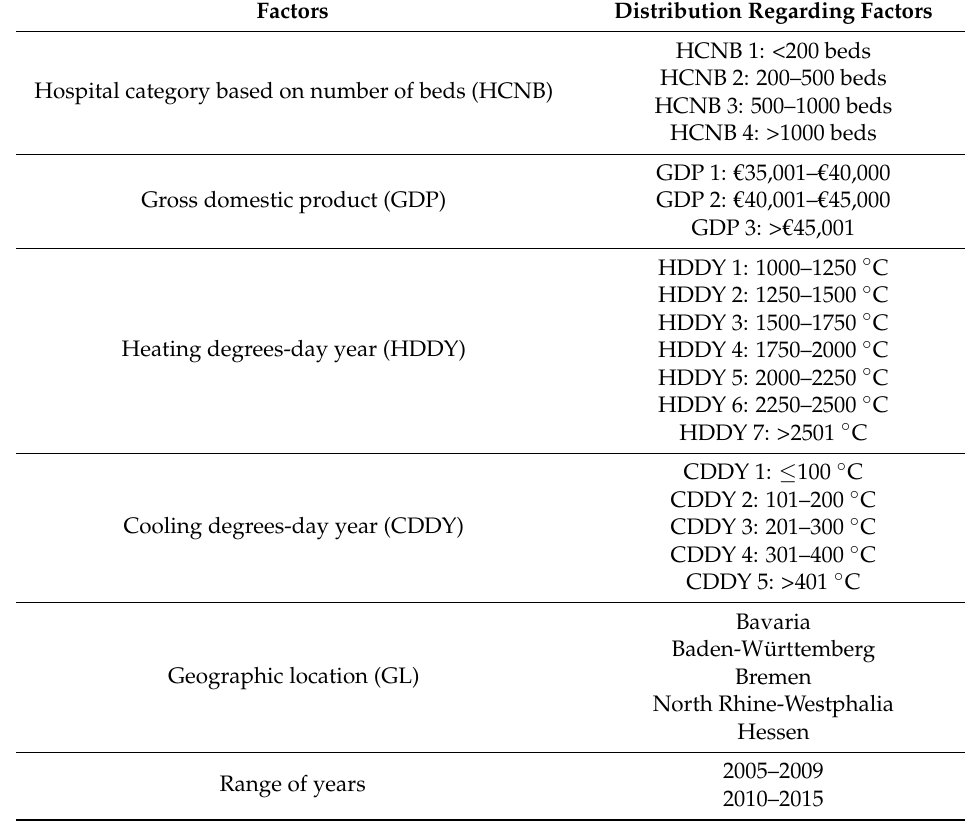
Table 1. Hospital rating factors.